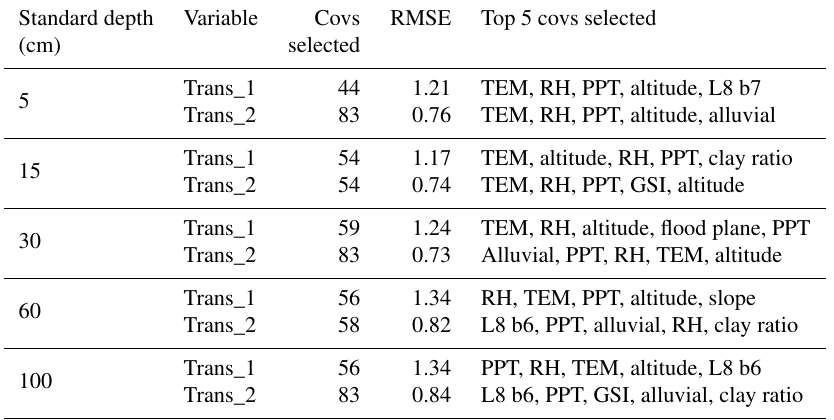
Table 3. Top five covariates selection for each transformation and standard depth. TEM: temperature, RH: relative humidity, PPT: precipita- tion, L8 b7: Landsat 8 band 7, L8 b6: Landsat 8 band 6, GSI: grain size